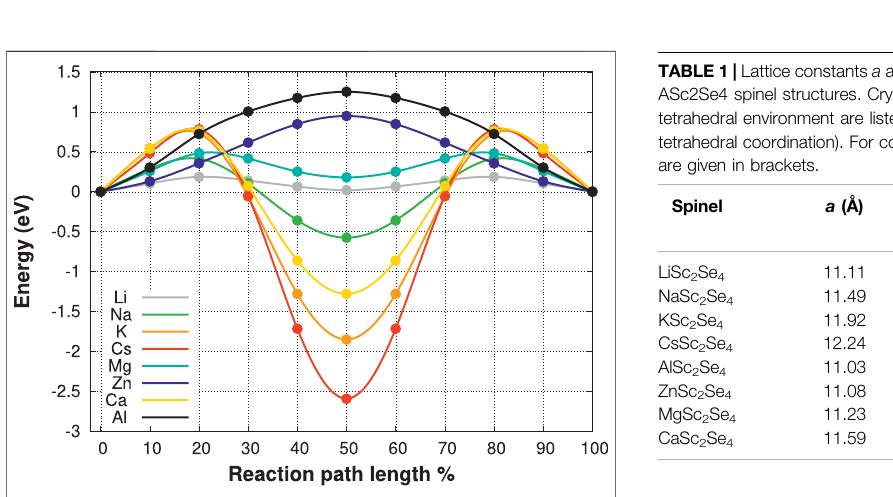
FIGURE 1 | (A) The AB 2 X 4 spinel structure. The “ X ” anions (red) form a face-centered cubic lattice, the “ B ” cations (gray) are octahedrally coordinated, and the “ A ” cations (green) occupy tetrahedrally coordinated sites and (B) the schematic representation of a diffusion path between two adjacent tetrahedral sites (tet-oct-tet). The migration path of an exemplary tet-oct-tet diffusion event is indicated by the light green atoms.